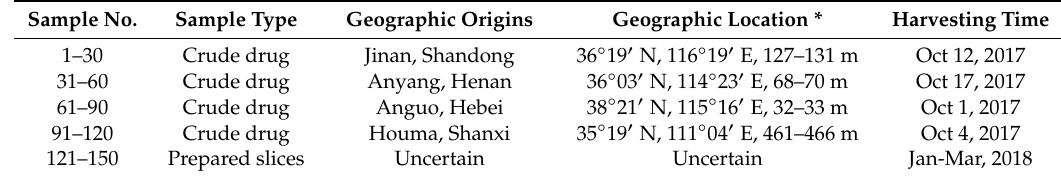
Table 3. A summary of Trichosanthis Fructus